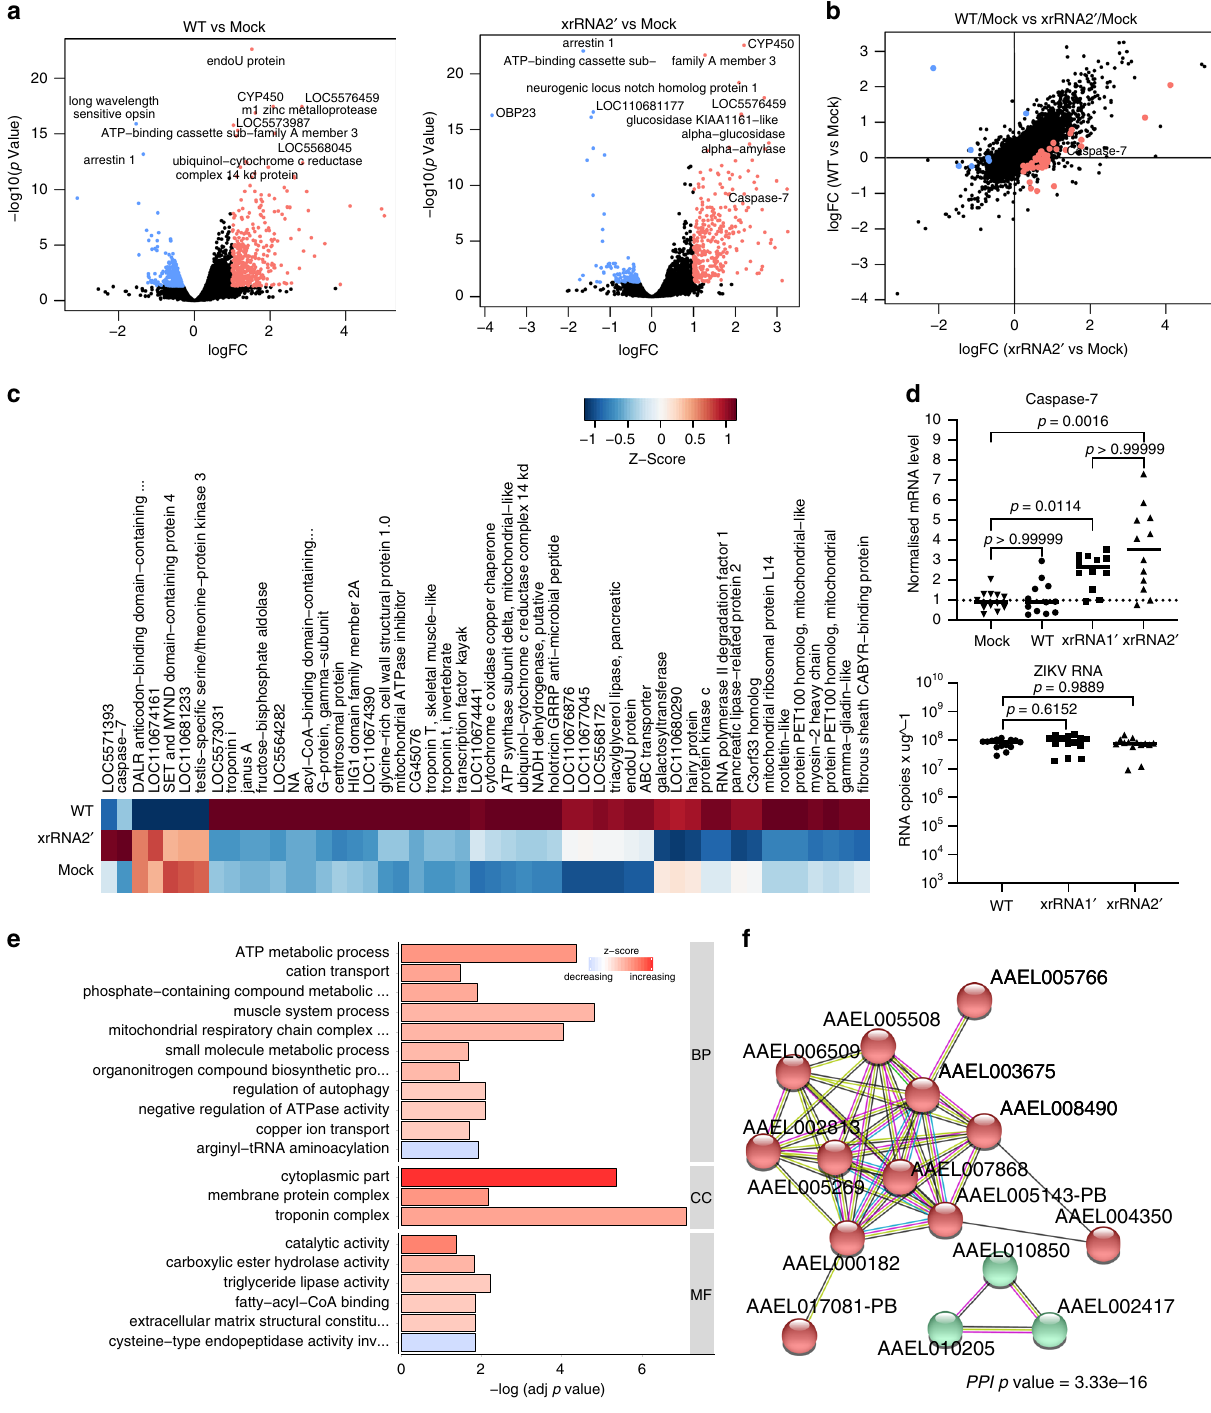
phosphate−containing compound metabolic ... muscle system process mitochondrial respiratory chain complex ... small molecule metabolic process organonitrogen compound biosynthetic pro... regulation of autophagy negative regulation of ATPase activity copper ion transport arginyl−tRNA aminoacylation cytoplasmic part membrane protein complex troponin complex catalytic activity carboxylic ester hydrolase activity triglyceride lipase activity fatty−acyl−CoA